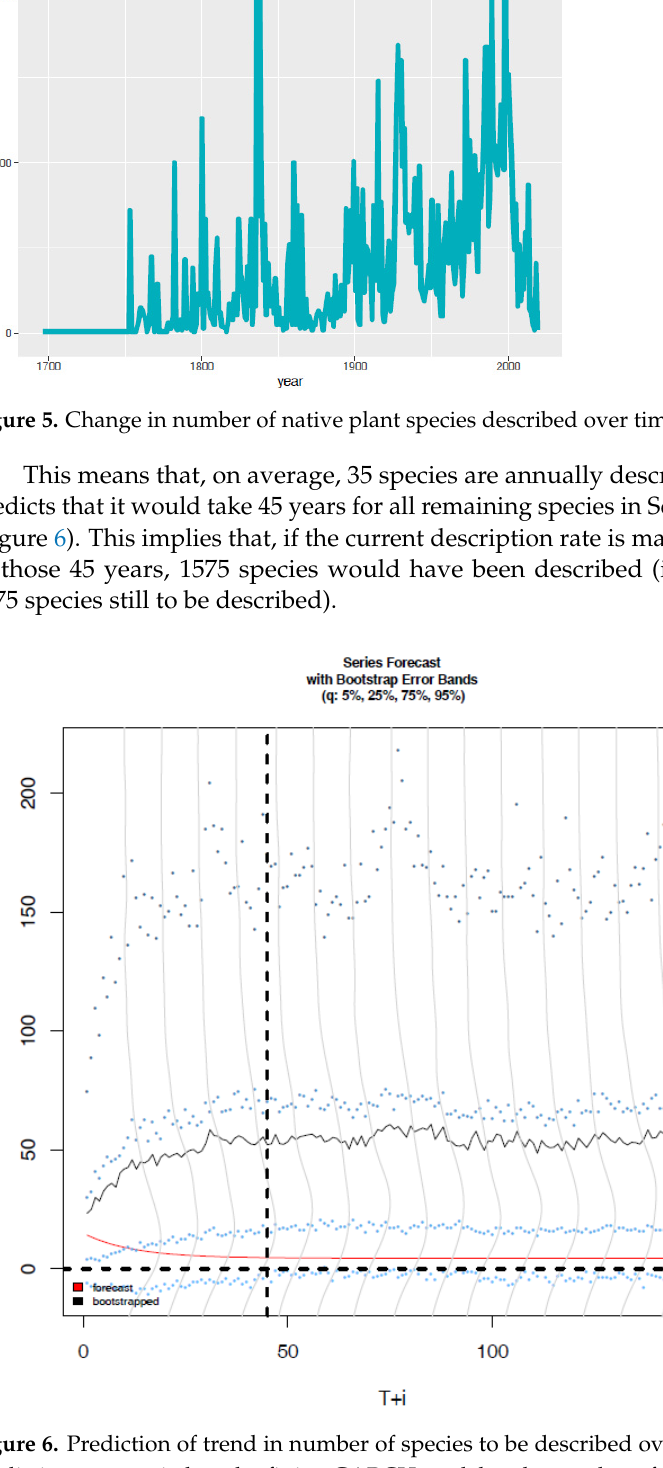
Figure 6. Prediction of trend in number of species to be described over time in South Africa. This prediction was carried out by fitting GARCH model to the number of South Africa’s native species described from 1696 to 2019. Red line corresponds to prediction of how the number of species to be described would be changing over the next 150 years. Vertical dashed bold line indicates number of years in which the number of species to be described would be 0, meaning that total number of species in the country would have been described. On the figure, this number corresponds to 45 years. Clearly, after 45 years, the number of species to be described (red line) does not change anymore, implying after 45 years the total number of species in the country would have been de- scribed. Horizontal bold dashed line shows the 0 value on the Y axis. The dotted lines indicate confidence intervals. 3.3. Efforts Required for a Comprehensive Plant Diversity Assessment Taking into consideration the fact that, in the past 323 years, 11,208 species have been described, implying a description rate of 35 species per year on average, it would take 45 years to describe the remaining 1575 species. This timeframe would be reduced to 40 years to describe the 1400 species predicted as unknown by experts. According to the results obtained from experts in this study, taxonomists have spent a total of ZAR 680,670,000 (USD 40,039,411) to describe 419 species. This implies that, in theory, ZAR 1,624,510.74 (USD 95,559) was spent, on average, to describe 1 species. At this rate, ZAR 2,558,604,415.00 (USD 150,506,142) would be required to describe the 1575 (modeling) remaining species or ZAR 2,274,315,036.00 (USD 133,783,237) for the 1400